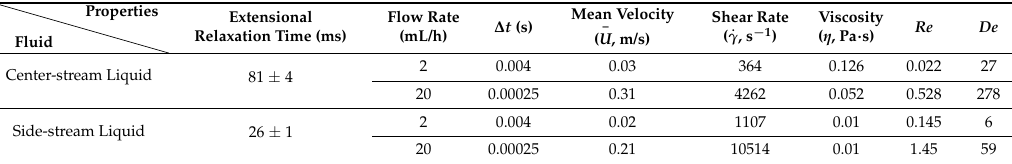
Figure 5. Schematic diagram of the two recording modes. ( a ) Mode 1. ( b ) Mode 2.